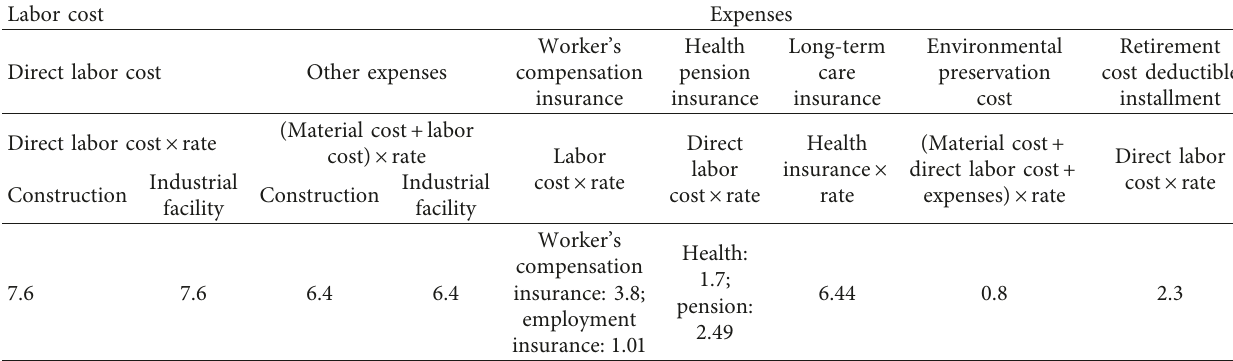
Table 2: Method for calculating the investment cost DB for economic